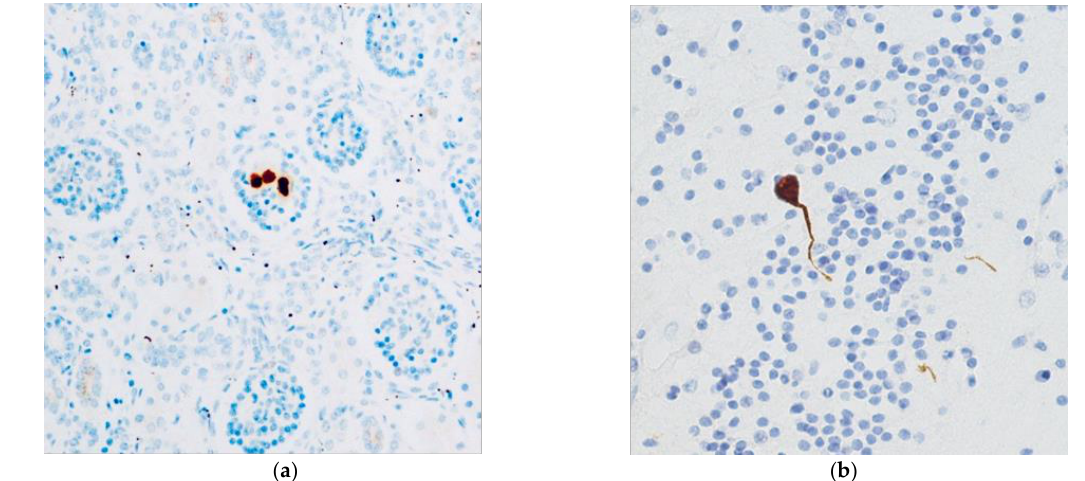
Figure 1. CMV-positive cells in kidney ( a ) and brain ( b ) (CMV-IHC; 4HPF) related to a widespread infection.